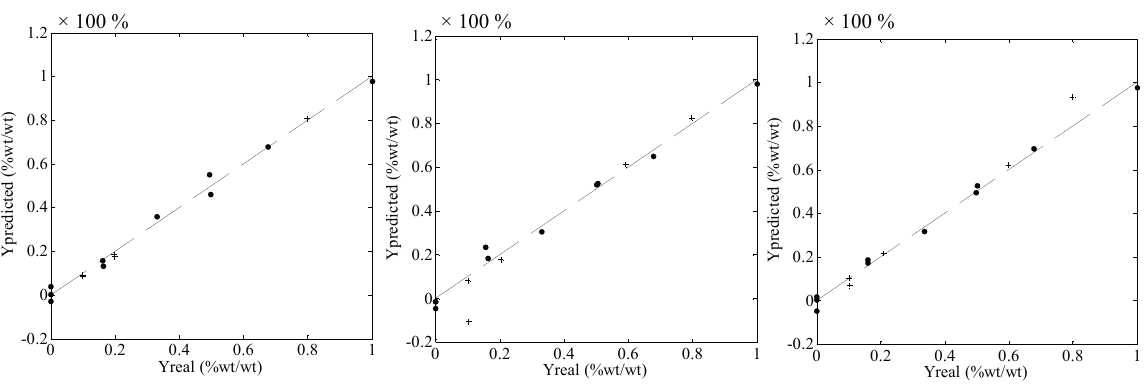
Figure 3. Real vs. predicted values for CBZ DH ( left ), CBZ I ( middle ) CBZ III ( right ). The percentage values consider the mass of a polymorph related to the total mass of carbamazepine. The straight line is the exact correlation between real vs. predicted values.